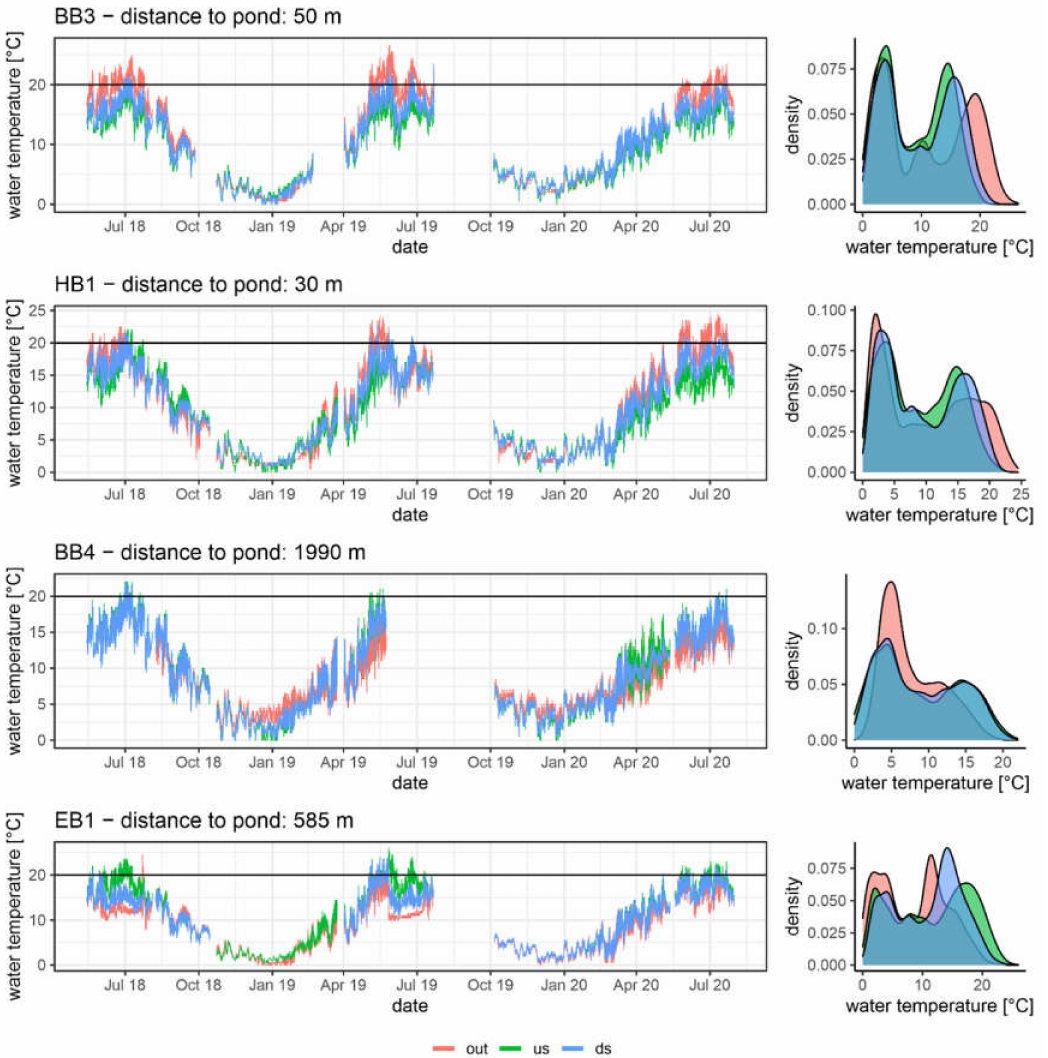
Figure 4. Hourly stream temperature at five sampling sites with water temperature measured at the ‘out’ (red), ‘us’ (green) and ‘ds’ (blue) monitoring points, solid line represents the limit of 20 ◦ C, the density plot on the right shows the proportion of a certain temperature measured at the monitoring points over the respective time